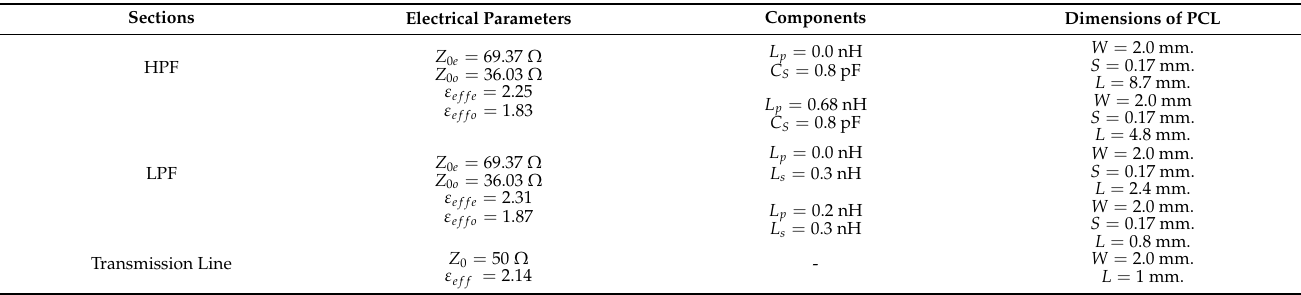
Table 1. Parameters for computer